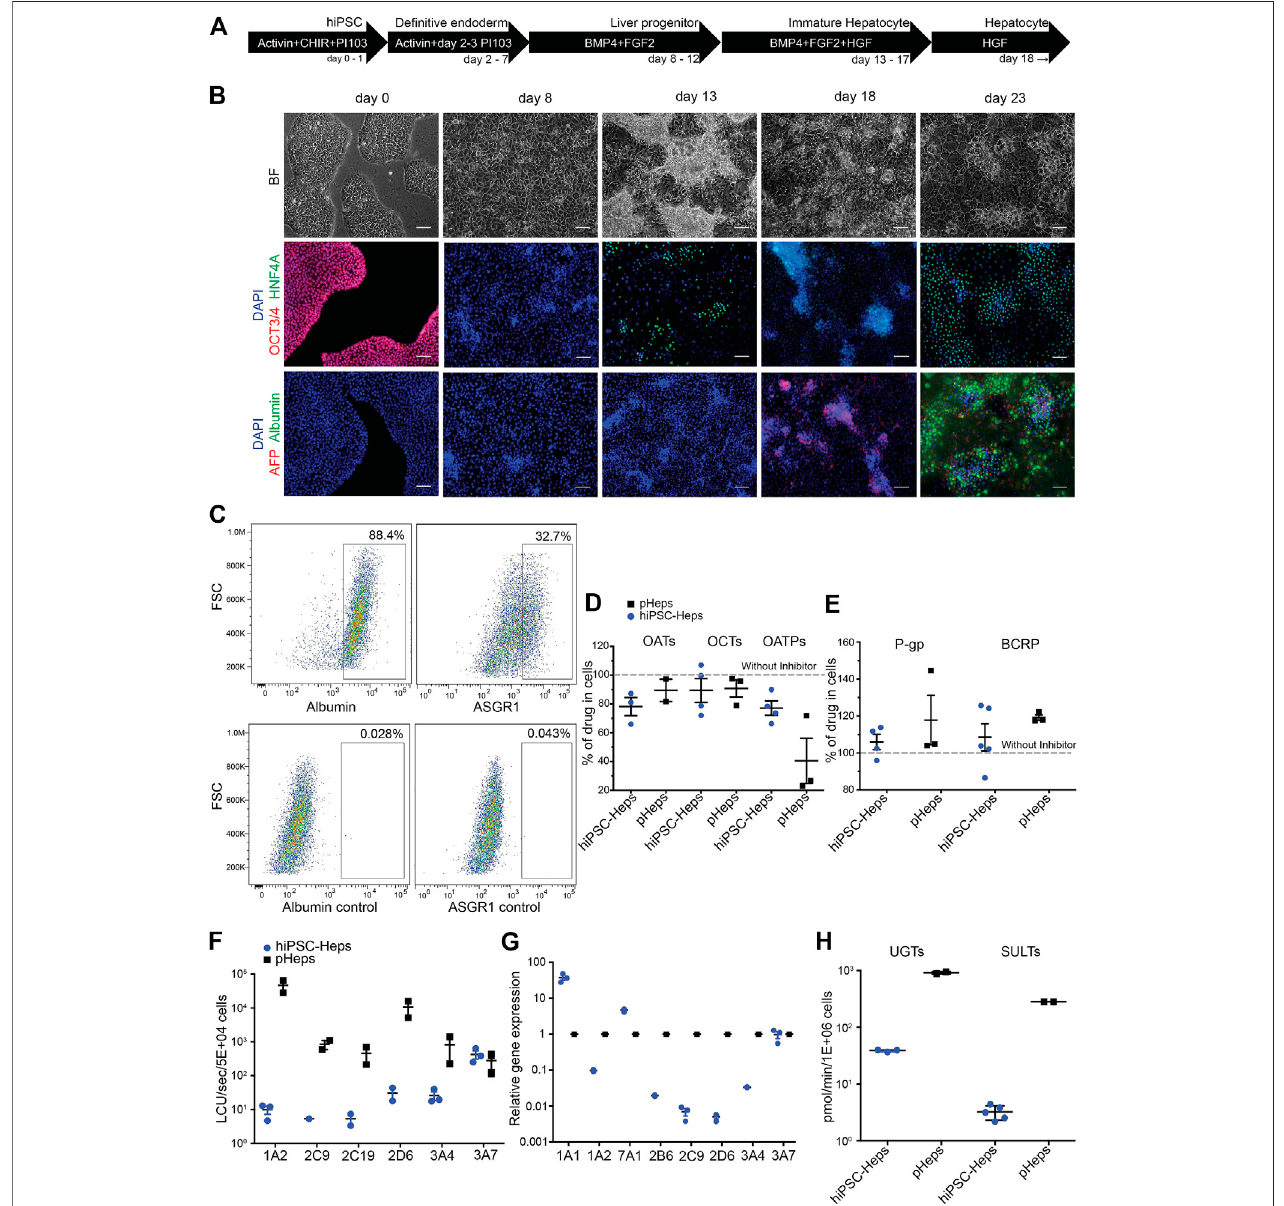
FIGURE 1 | Differentiation and characterization of hiPSC-Heps. (A) Schematic of the hiPSC-Hep differentiation protocol. The arrows show cells at different stages progressingfromhiPSCs(day0)tomaturehepatocytes (day23). Growthfactorsandsmallmoleculesarelisted insidethearrows. (B) Bright fi eldandimmuno fl uorescent images matching the differentiation stages in (A) . Nuclei were stained with DAPI. Scale bars, 100 µm. (C) Flow cytometry shows percentage of hiPSC-Heps expressing albuminandASGR1atday23. (D) Activityanalysisofuptaketransportersbyinhibitionwithspeci fi cinhibitors.Resultsobtainedwithoutinhibitorsweresetto100% todisplaytransporteractivityasdecreaseofdrugconcentrationinthecells.Dataarepresented asthemean ± standarddeviationfromthreetofour(hiPSC-Heps)ortwo to three (pHeps) independent experiments. (E) Activity analysis of ef fl ux transporters by inhibition with speci fi c inhibitors. Results obtained without inhibitors were set to 100% to display transporter activity as increase of drug concentration in the cells. Data are presented as the mean ± standard deviation from four to fi ve (hiPSC-Heps) and three(pHeps)independentexperiments. (F) ActivityanalysisofCYPs.Dataarepresented asthemean ± standarderrorofthemeanfromthree(hiPSC-Heps)ortwo (pHeps)independentexperiments. (G) QuantitativereversetranscriptionPCRanalysisofCYPgenes. (H) Activityanalysisofconjugatingenzymes.Dataarepresentedas the mean ± standard deviation from two (UGTs, SULTs; pHeps), three (UGTs; hiPSC-Heps), or fi ve (SULTs; hiPSC-Heps) independent experiments.